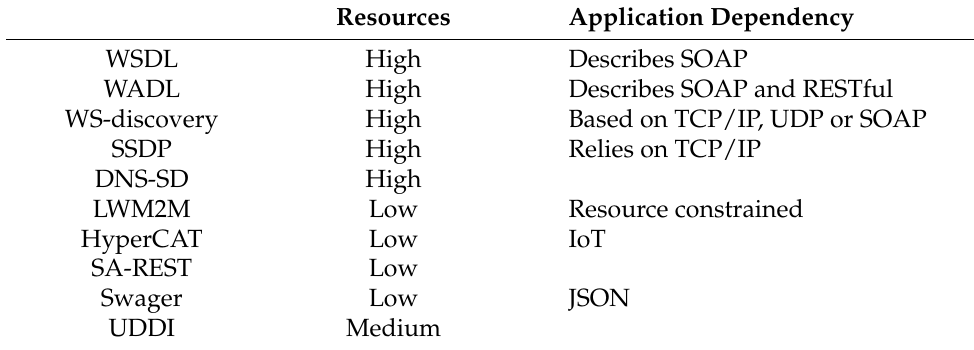
Table 6. Comparison of resource discovery and catalogue technologies.